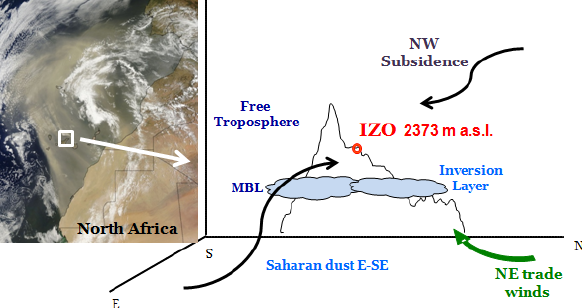
Figure 1. (a) MODIS/Terra image showing a strong Saharan dust outbreak over the study area (the Canary Islands) on 25 June 2012; (b) vertical cross section of Tenerife with a scheme of the vertical atmospheric stratification (marine boundary layer (MBL), inversion layer, and free troposphere) and the main atmospheric flows affect- ing IZO (NW clean subtropical subsident air masses, low-level NE trade winds, and E–SE Saharan dust intrusions). This figure has been adapted from González et al.